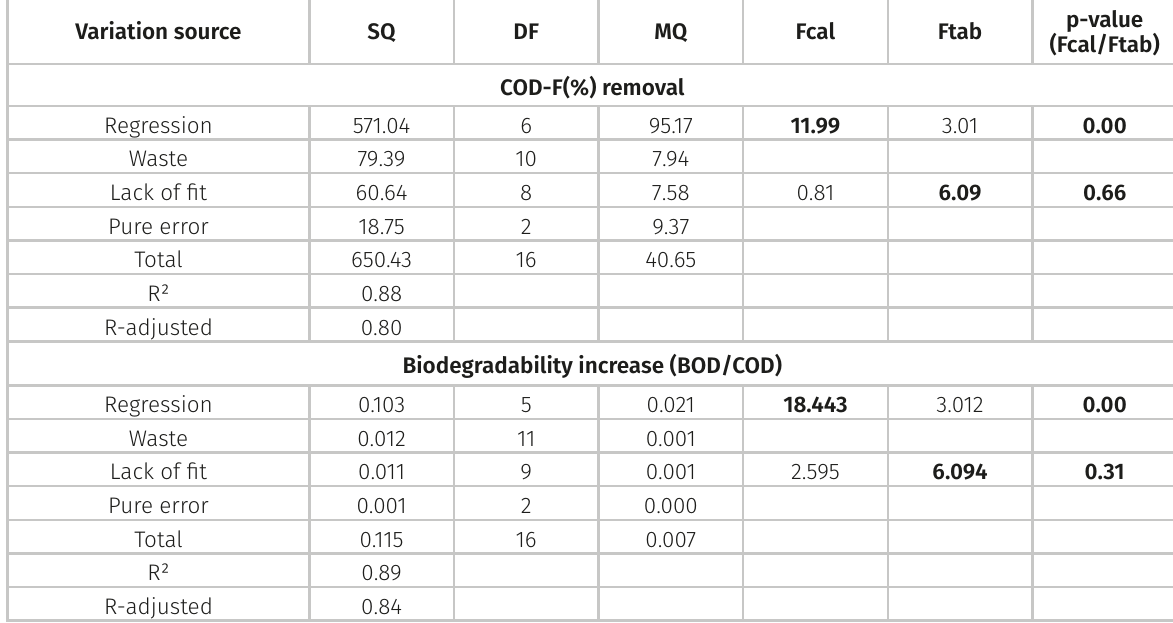
Table VIII . Analysis of variance (ANOVA) of the statistical model to increase biodegradability (BOD / COD). Variation